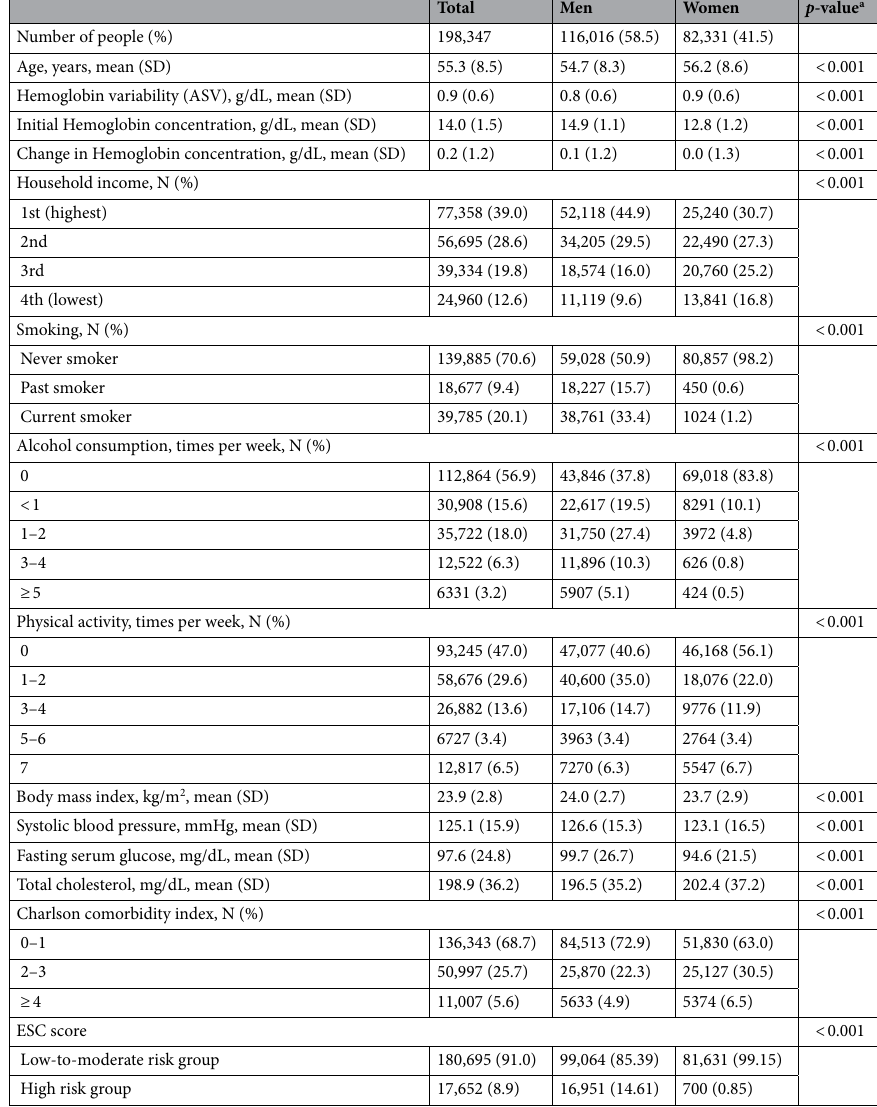
Table 1. Descriptive characteristics of the study population. ASV average successive variability, SD standard deviation, N number of people. a p -value calculated by chi-square test or t-test according to